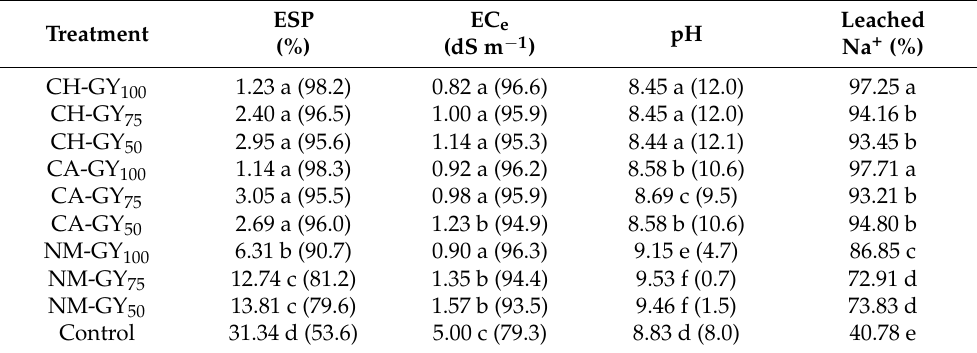
Table A1. Effect of manures combined with gypsum levels on soil properties, compared to control.